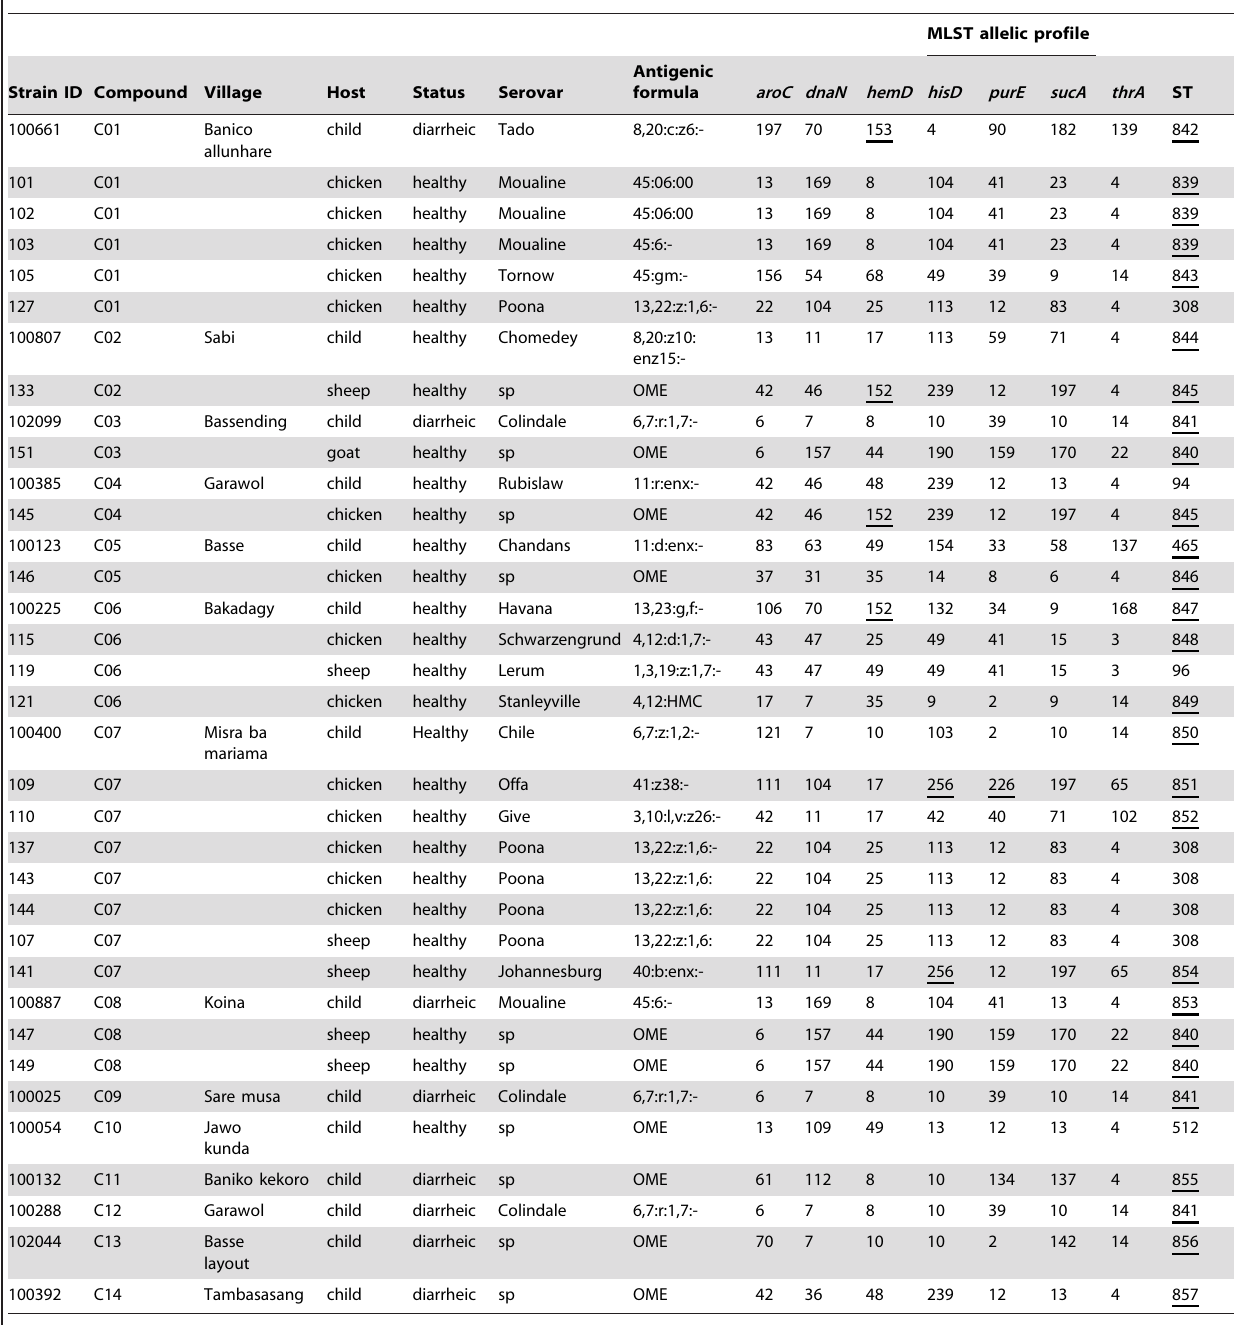
Table 1. Salmonella strains isolated from humans and animals in the same compound and their Sequence Types